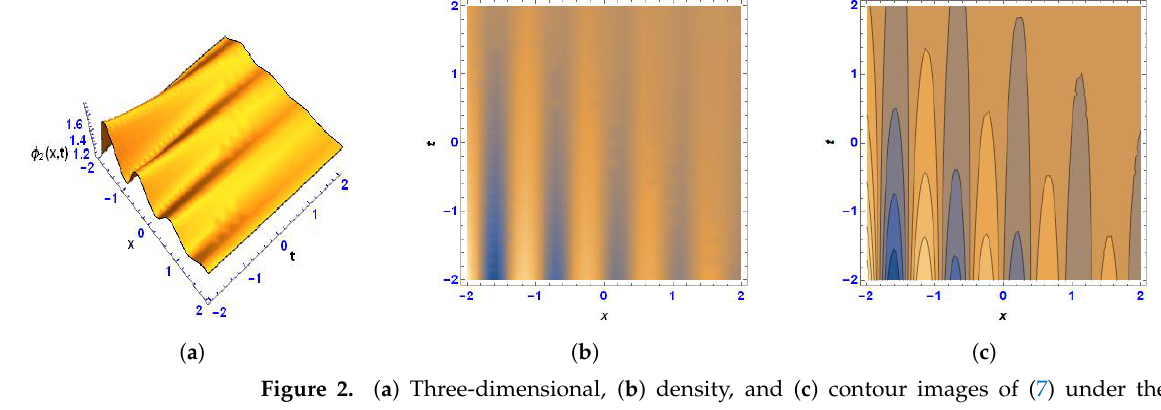
Figure 2. ( a ) Three-dimensional, ( b ) density, and ( c ) contour images of (7) under the values ϑ 0 = − 7, γ 1 = − 9.55, ϑ 1 = 0.471.